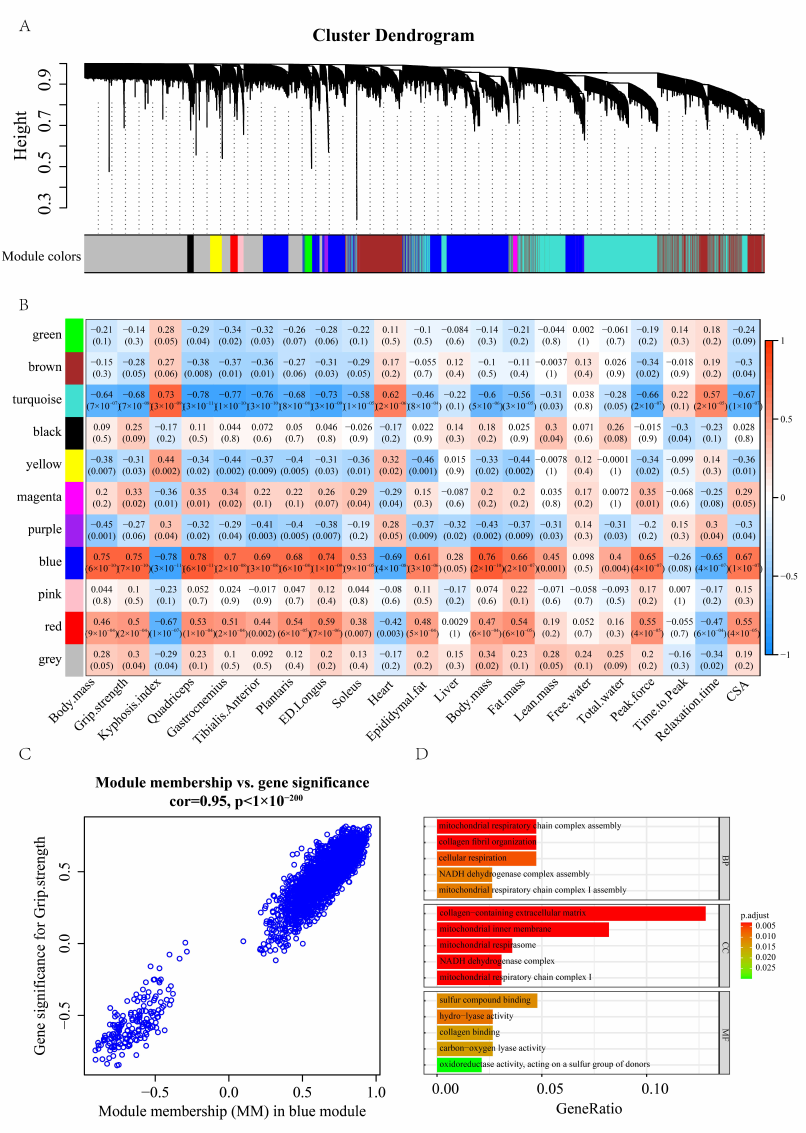
Figure 6. ( A ) Cluster dendrogram of the 50 mouse samples in GSE145480. ( B ) Heatmap of the corre- lation between the module eigengenes and mouse phenotype. ( C ) Visualization of gene significance (GS) vs. module membership (MM) and gene expression levels of the green module. ( D ) Gene ontology enrichment analysis of the 43 significant genes (Section